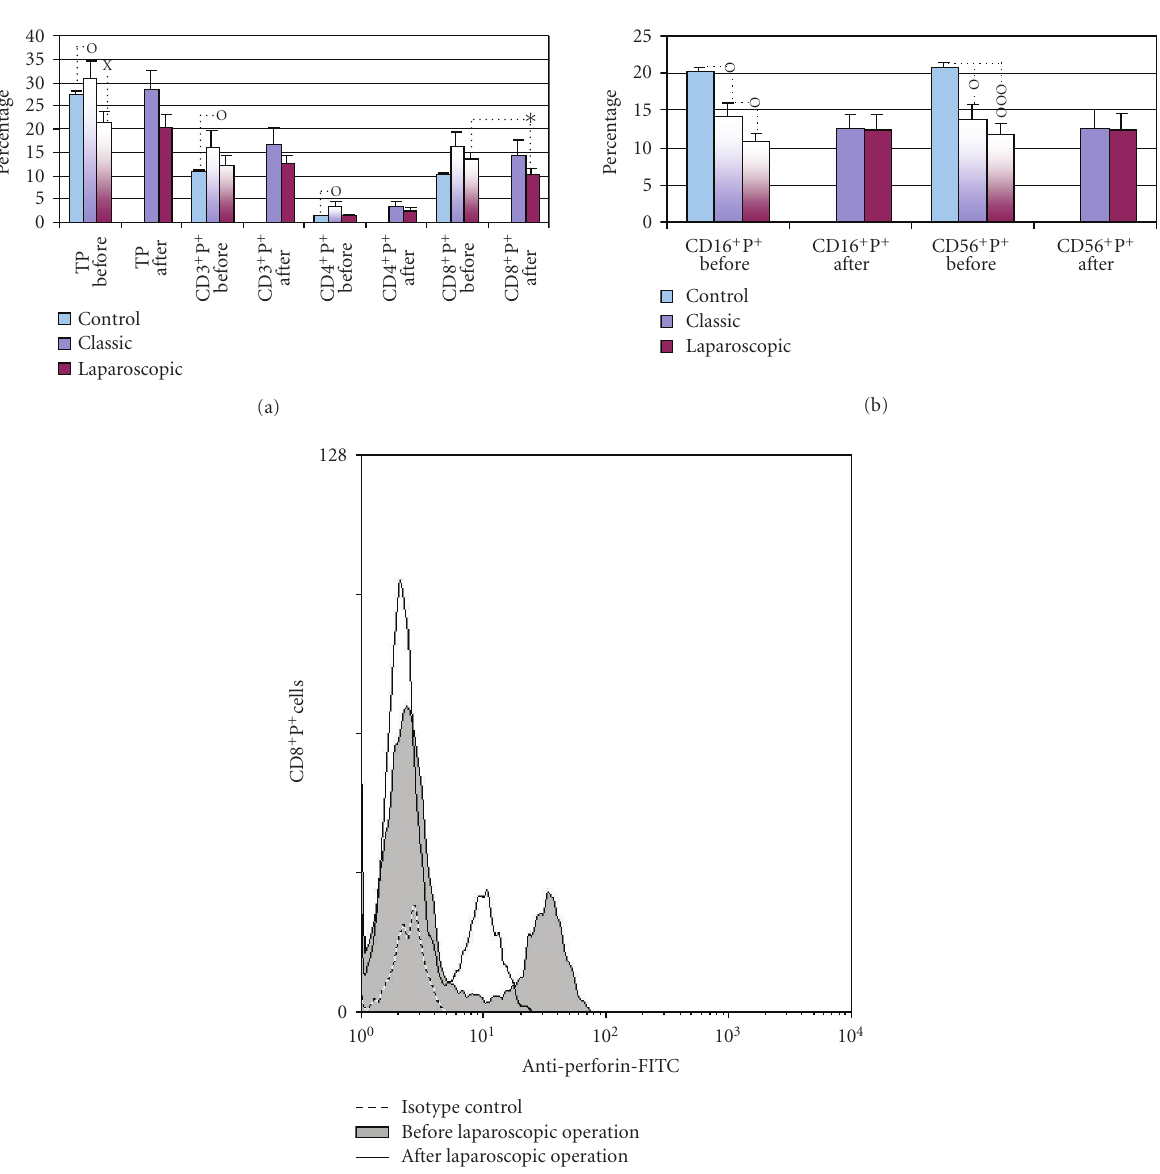
Figure 3: Percentage of total number of perforin positive cells (TPs) and double positive (perforin positive (P + ) and surface marker positive) T lymphocytes (a) or NK cells (b) (mean percentage ± S.E.M.) in peripheral blood from patients subjected to classic or laparoscopic cholecystectomy before (two-colored columns) and after operation (one-colored column) compared to healthy control (first, blue column). O - statistical significance toward healthy control; X-statistical significance between the preoperative values in classic and laparoscopic cholecystectomy; ∗ statistical significance between the preoperative and postoperative values in classic or laparoscopic cholecystectomy. One mark P < . 05, two marks P < . 01, three marks P < . 001. (c) Representative flow cytometric profile of perforin expression on the gated CD8